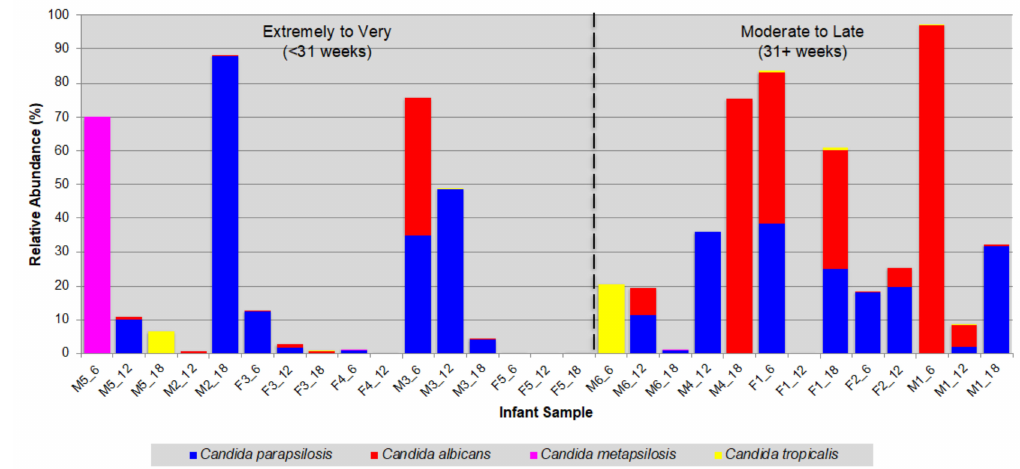
Figure 3. Bar graph of the prevalence and abundance of human-associated Candida species in the preterm infant gut mycobiome. Samples ordered according to infant gestational age at birth.